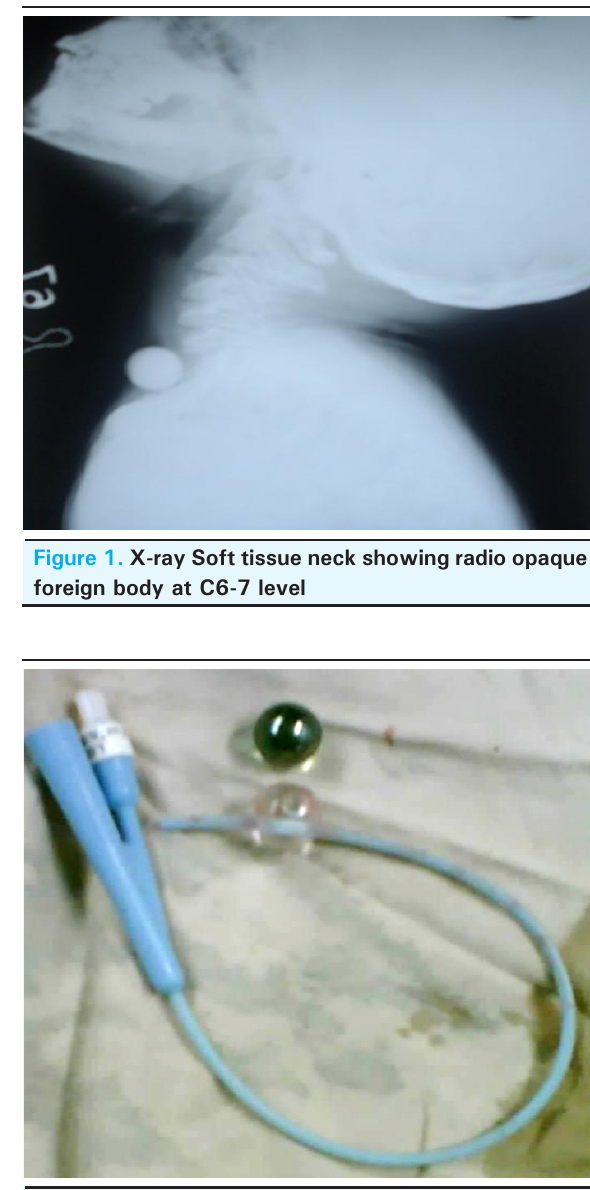
figure 2. Marble and foley’s catheter after